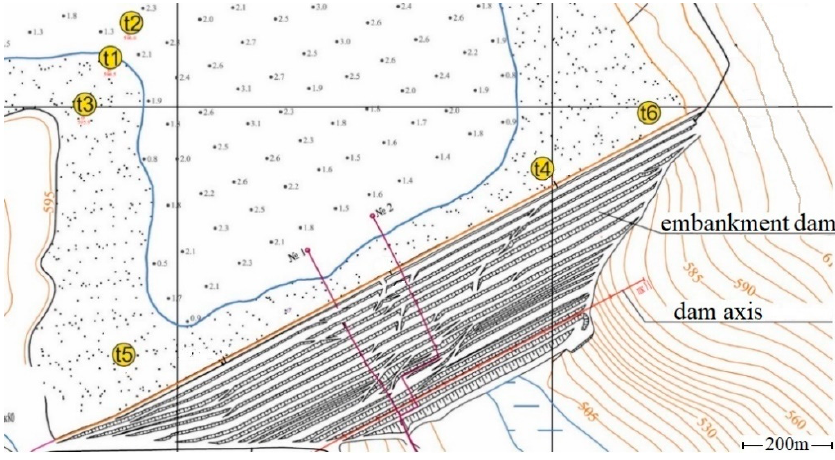
Figure 2. Schematic diagram showing locations of wells t1–t6 on the dam plan. Surface water samples of 1 L volume were taken at 20 points in the settling pond (Figure 3) from surface, near-surface (0.2 m depth), and bottom (2 m depth) horizons. In situ, a portion of the sample (50 mL) was filtered using a membrane filter with a pore size of 0.25 µ m and acidified with concentrated distilled nitric acid (500 µ L per 50 mL sample) to preserve the sample and further determine its trace element composition. In addition, the trace element composition of another portion of the filtered but unacidified sample was also determined.